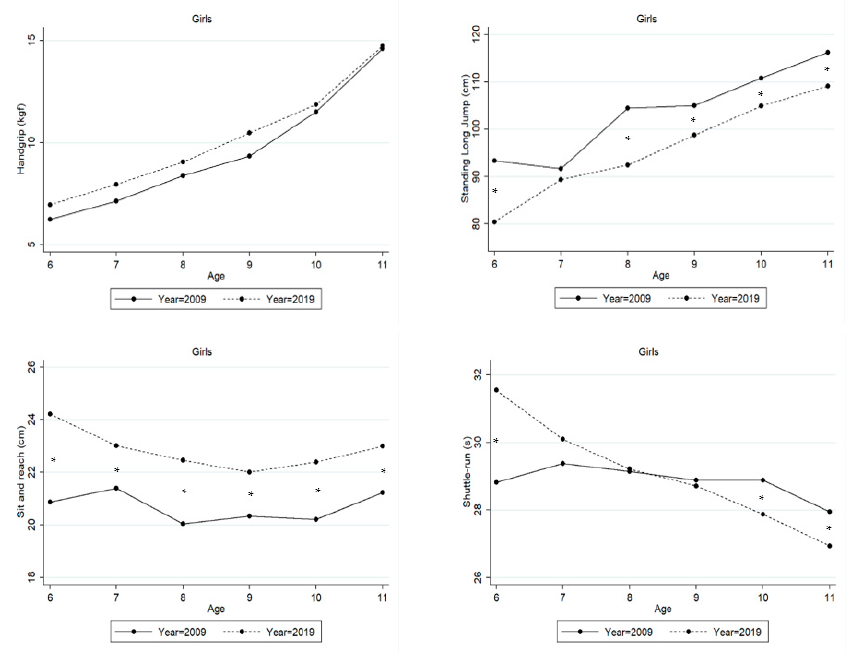
Figure 1. Means of Peruvian girls’ physical fitness between 2009 and 2019. Significant differences are marked by *.